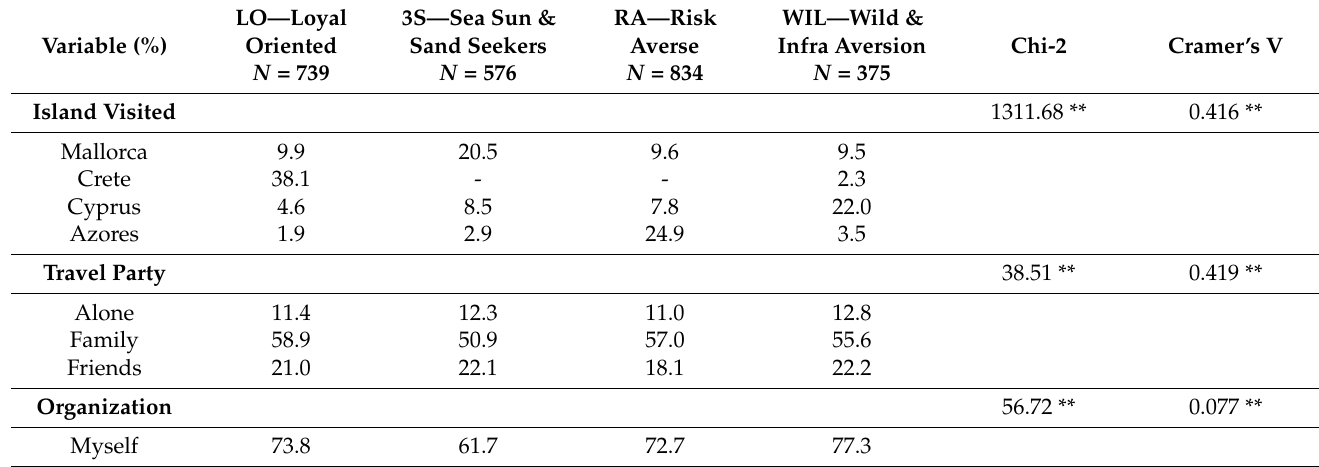
Table 5. Tourist segments’ travel characteristics (** p <